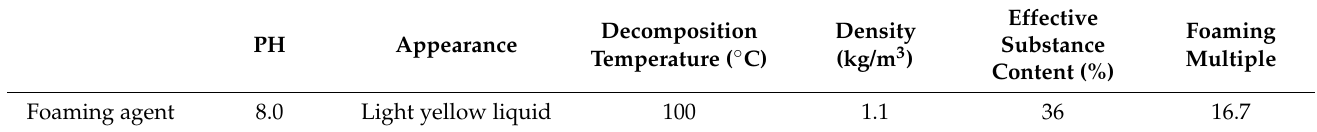
Table 3. Foaming agent technical indexes.